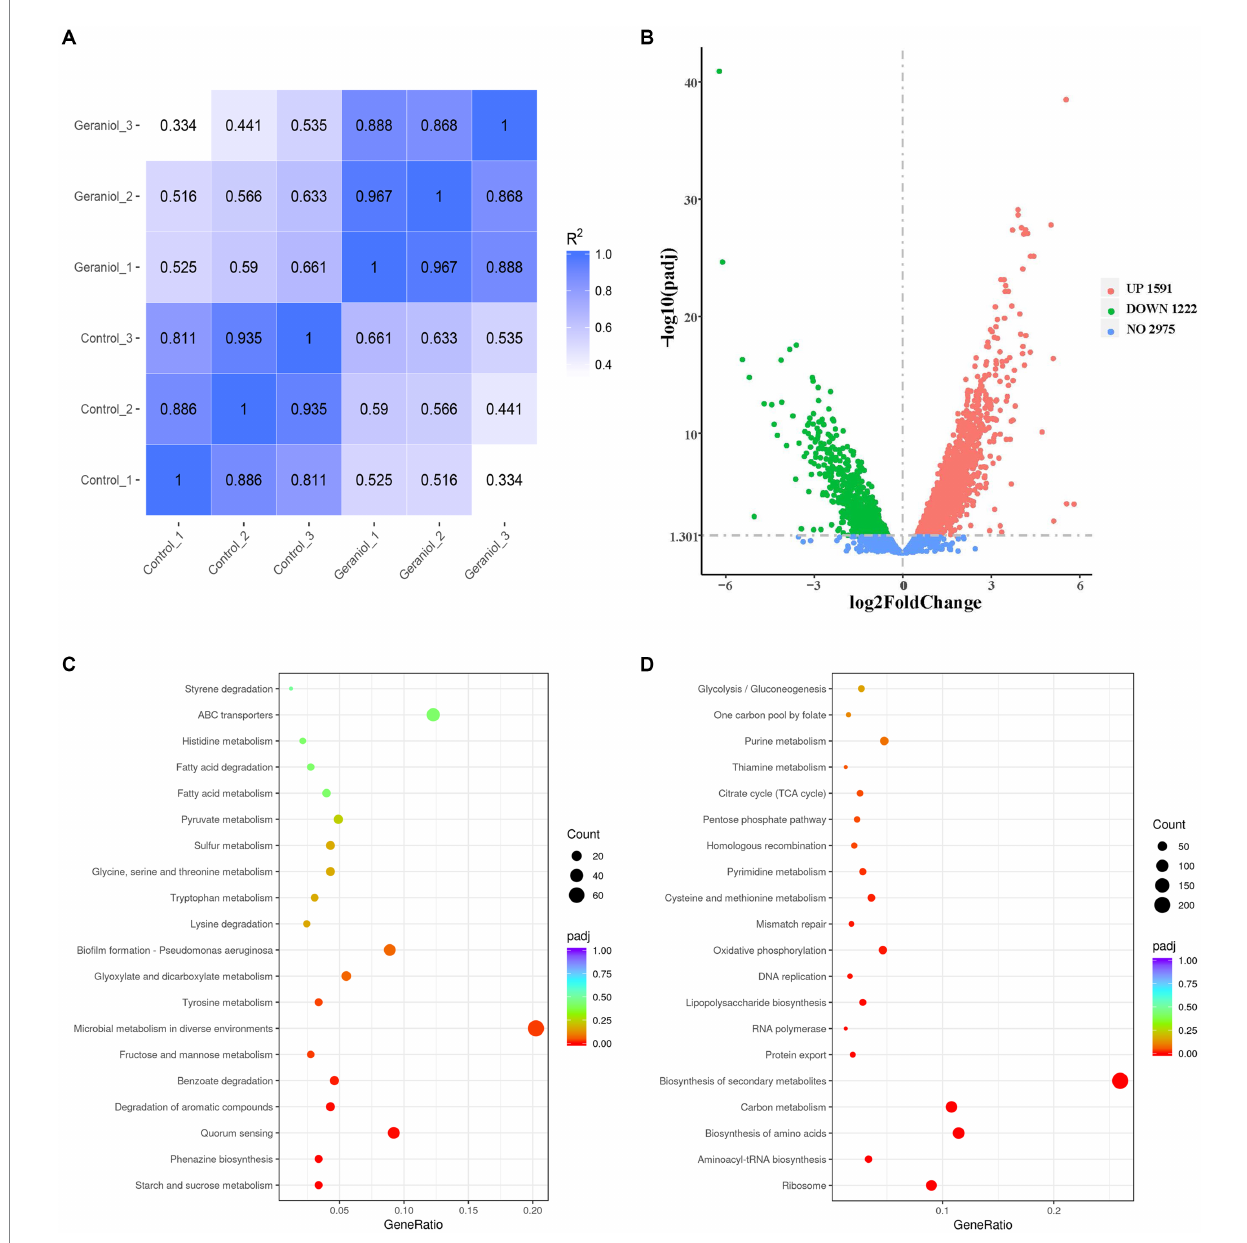
FIGURE 2 Maps of Pearson correlation coefficients, volcano plots, and Kyoto Encyclopedia of Genes and Genomes (KEGG) enrichment pathways based on RNA- seq data of three control and three treatment groups of Pseudomonas aeruginosa PAO1 with 1.1 mg/mL geraniol (0.00 < q < 0.05). (A) Pearson correlation coefficients map. (B) Volcano plots of differentially expressed genes. The red and green dots represent upregulated genes and downregulated genes with >2-fold change, respectively. (C) Bubble map of the top 20 KEGG enrichment pathways of downregulated genes with >2-fold change. (D) Bubble map of the top 20 KEGG enrichment pathways of upregulated genes with >2-fold